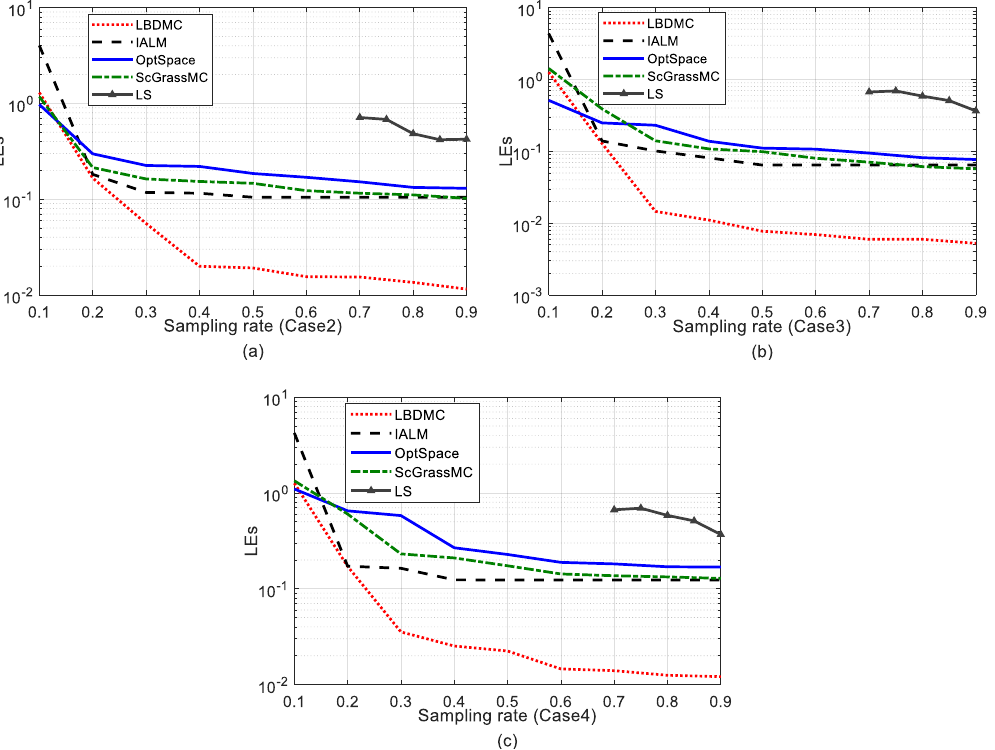
Figure 5. Mean localization error versus different sampling rates. The sampling rate varies successively from 10% to 90%. ( a ) Mean localization errors under Case 2: ( b ) Mean localization error under Case 3; ( c ) Mean localization error under Case 4.